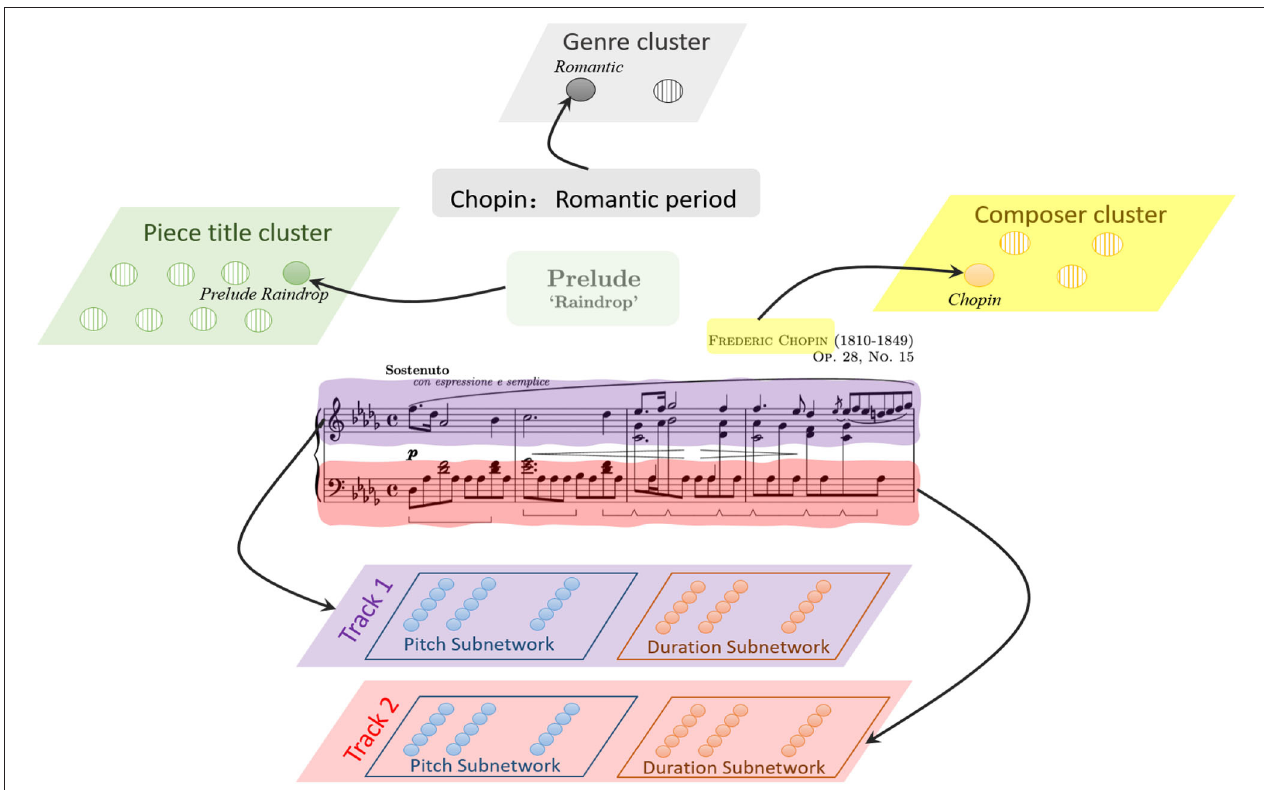
FIGURE 2 | The representation of a music piece in our model, the basic information, including the genre, composer and title are encoded by corresponding cluster in knowledge system, while the music notes are encoded in sequential memory system.